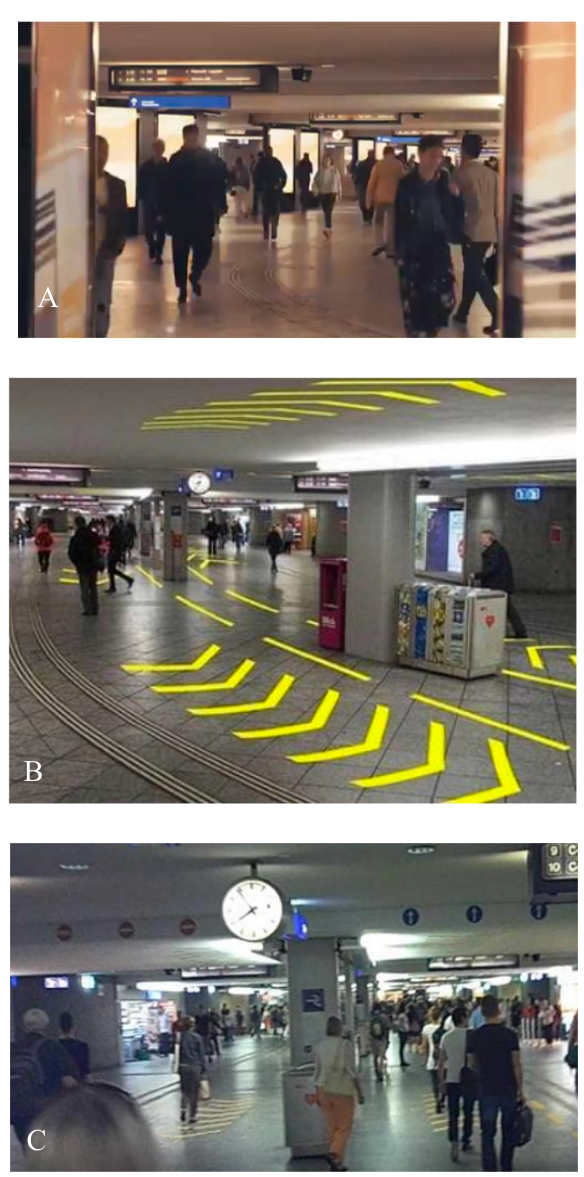
Figure 1 . Train station passage before implementation of the signaling prototype (control condition) (A). The yel- low arrows on the floor and ceiling, and the blue and red one-way signals at the entrance of the passage are in- stalled as a prototype to regulate pedestrian flow (post- intervention condition) (B and